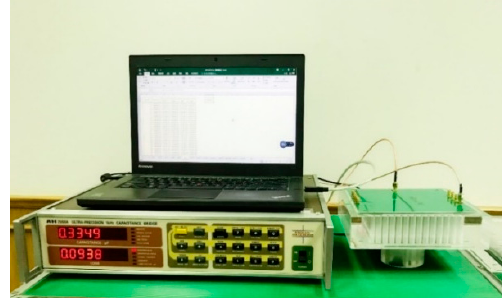
Figure 7. The experimental setup.